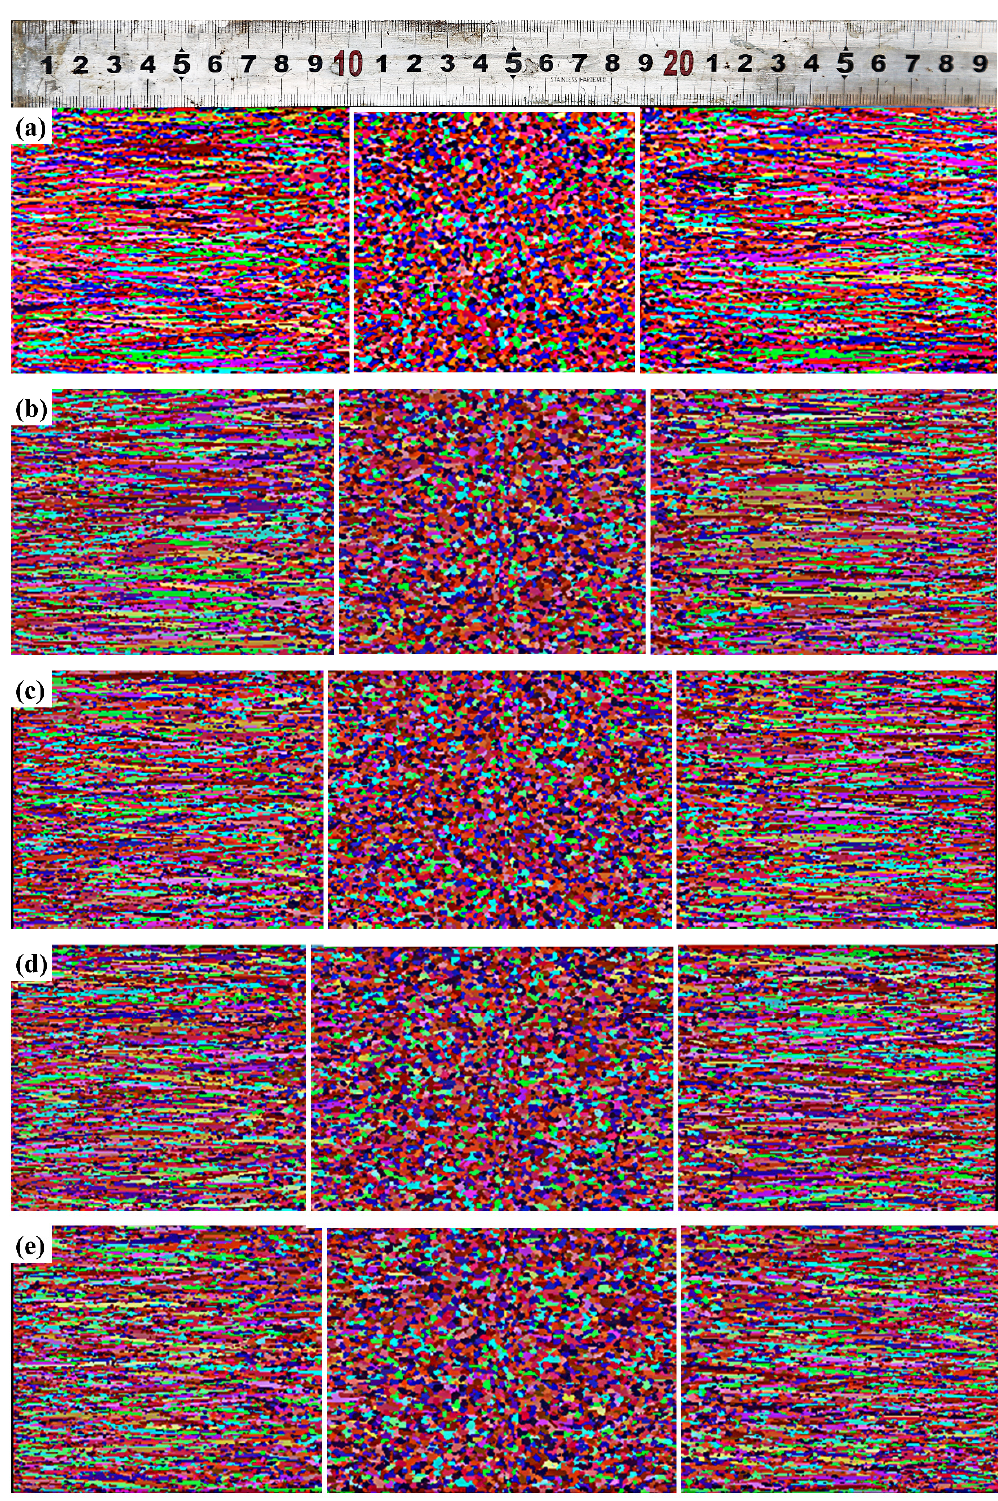
Figure 12. The simulated solidification structures of different slabs: ( a ) S-3; ( b ) C-0.20; ( c ) C-0.25; ( d ) C-0.30; ( e ) C-0.35.